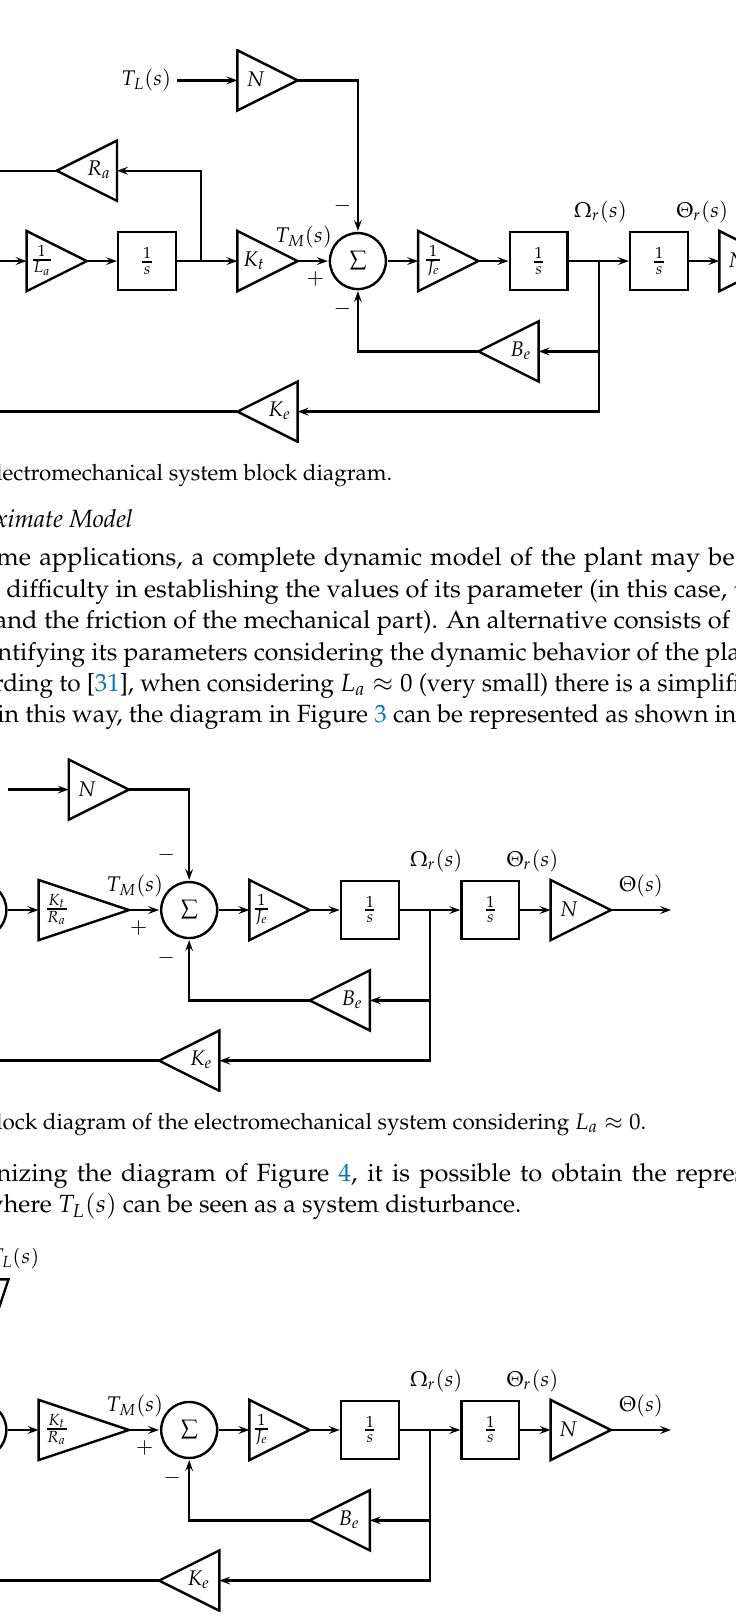
Figure 5. Simplified block diagram of the electromechanical